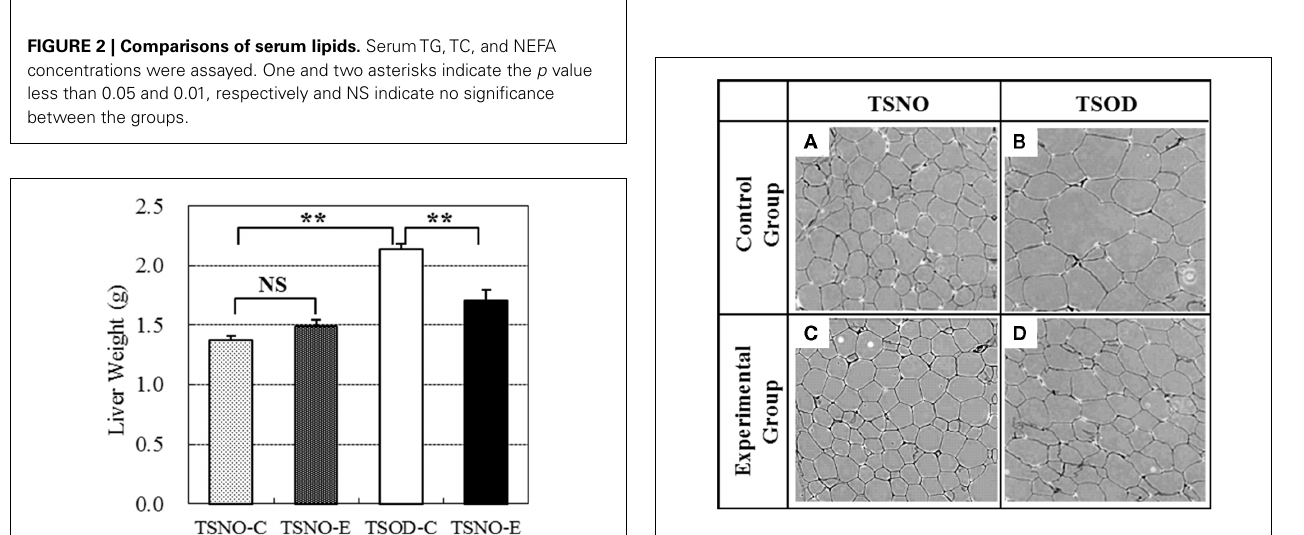
FIGURE 4 |Weights of visceral adipose tissues. Three visceral adipose tissues, epididymal (Epi.), perirenal (Peri.), and mesenteric (Mes.) adipose tissues, were removed and the weights were compared. Percentages in the column ofTSOD-E represent the rate of weight reduction compared to TSOD-C. Statistic difference was analyzed against total weight of three tissues; two asterisks indicate the p value less than 0.01 and NS indicates no significance between the groups.